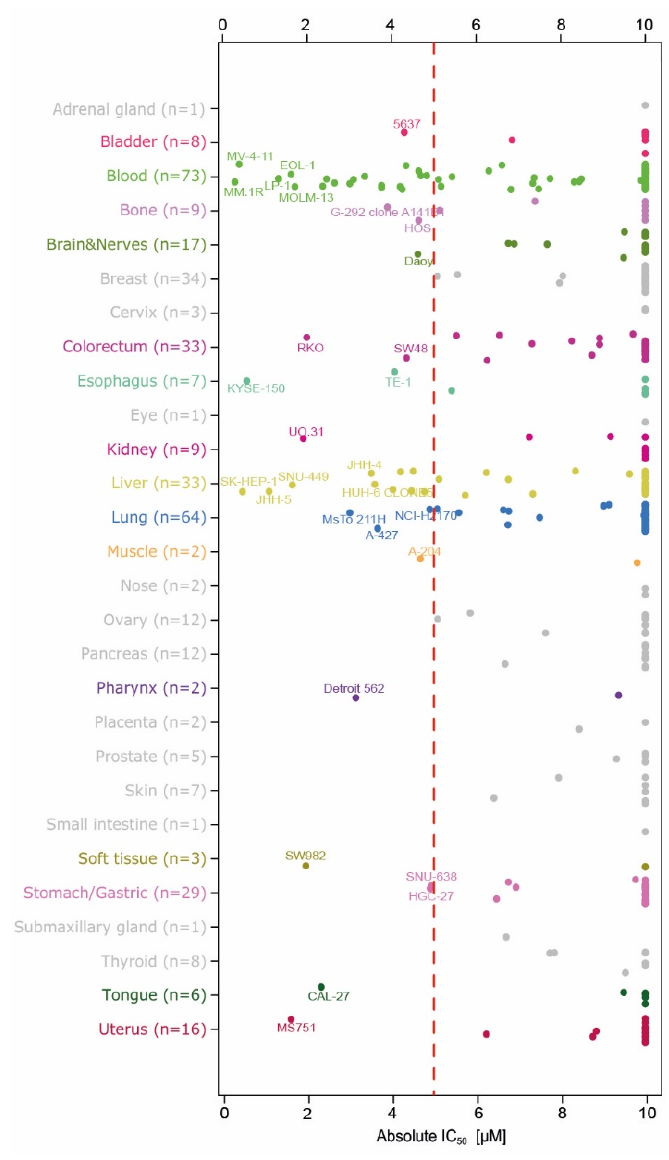
Figure 2. Anti-proliferative activity of BAY-155 in a cancer cell line panel. Sensitive cell lines are indicated to the left of the red dashed line (IC 50 < 5 µ M). For each tissue of origin, up to five highly sensitive cell lines are indicated by name.